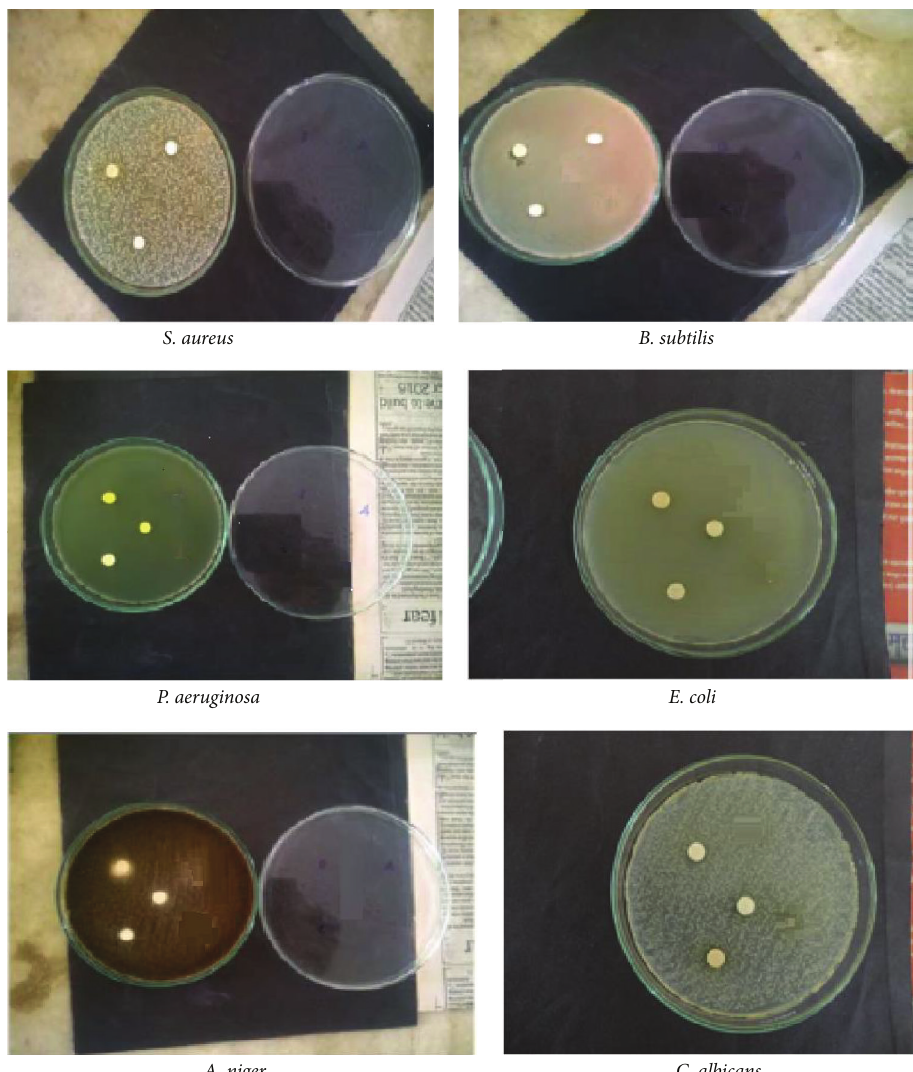
Figure 7: Antimicrobial studies of Pd (II) complexes.